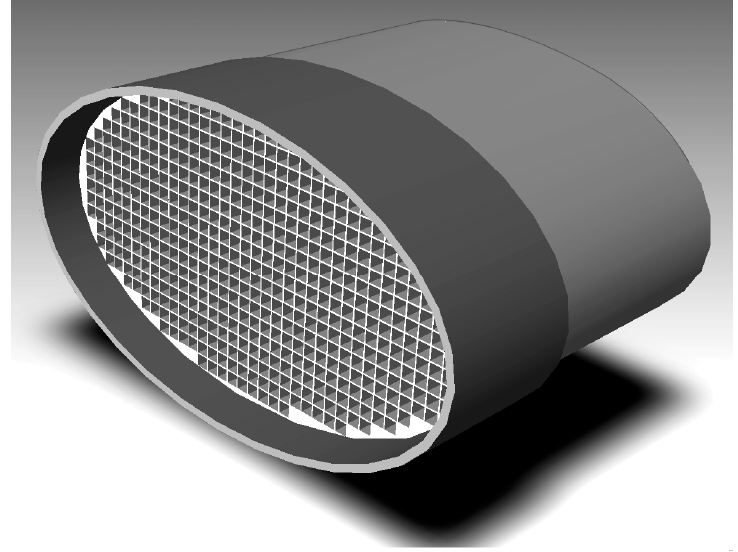
Figure 1. Ceramic monolithic matrix in a version resembling those used in car exhaust gas aftertreatment. Modern catalytic reactors for internal combustion engines are generally larger than this example, with very fine channels (around 100–250 parallel passages of millimetre size in the horizontal row). The typical elliptic shape seen here makes easier fitting into the usual underfloor car locations.